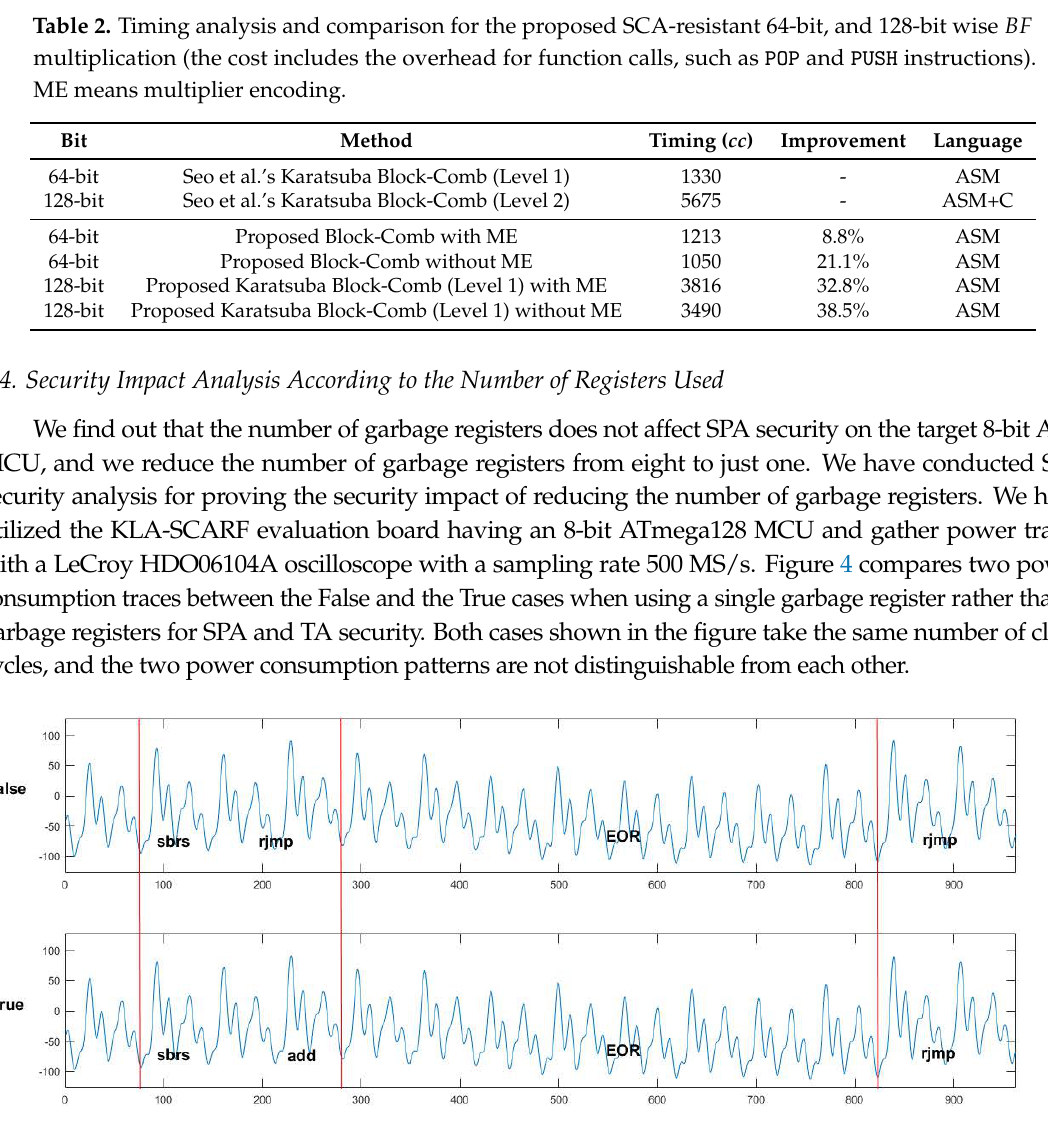
Figure 4. Comparison of power consumption patterns between the False case and the True case when using a single garbage